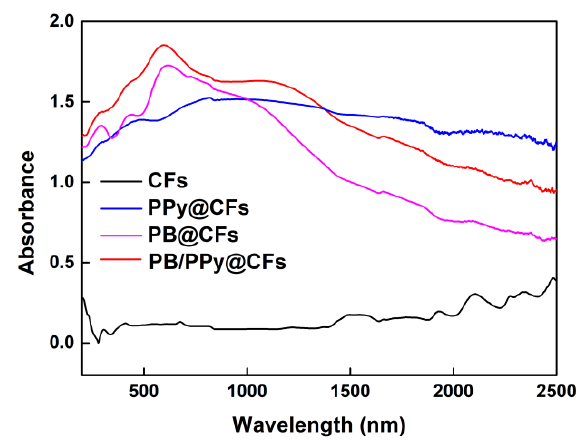
Figure 7. UV-Vis-NIR absorption spectra of CFs, PPy@CFs, PB@CFs, and PB/PPy@CFs in the wavelength range of 200–2500 nm.